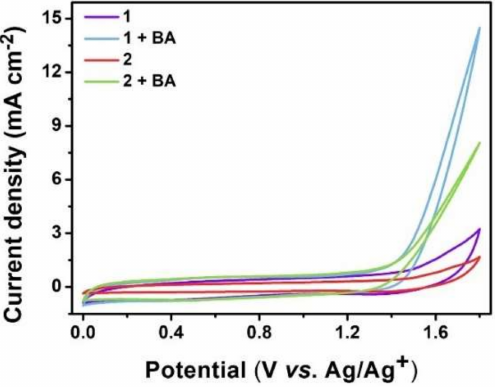
Figure 4. CV curves of 1 and 2 with BA (0.5 mmol) and without BA, obtained with a carbon cloth working electrode modified with 1 or 2 at a scan rate of 40 mV s − 1 .